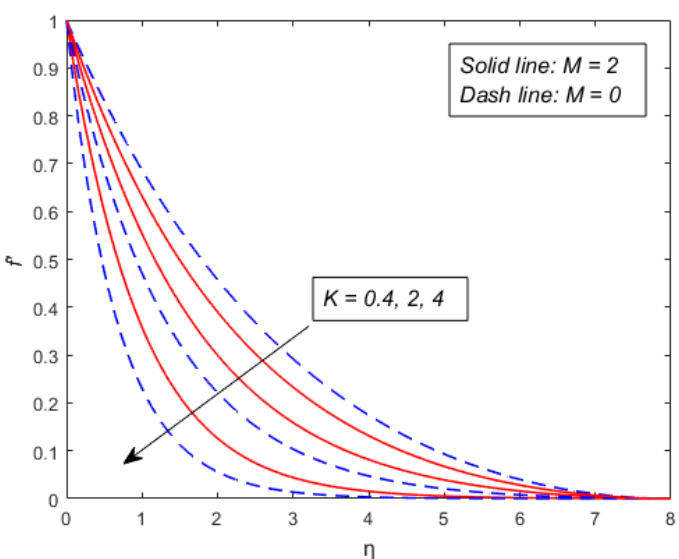
Figure 5. Variation of the velocity profile for different values of viscoelastic parameter K and magnetic parameter M for n = 3, Pr = 0.71, and Ec = 0.1.